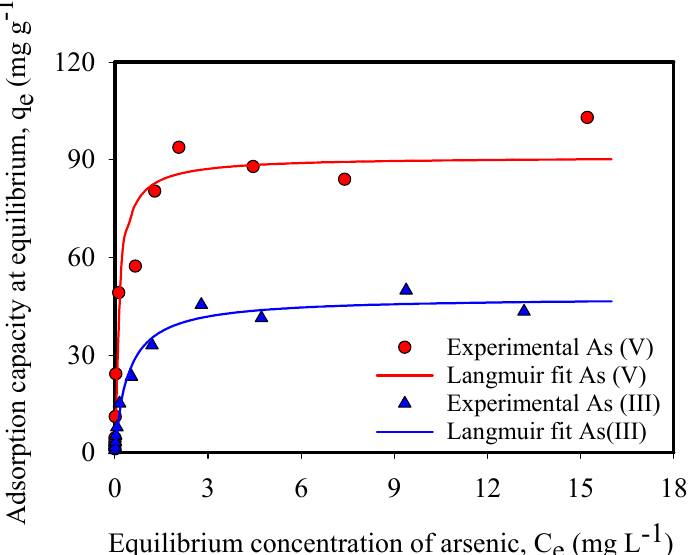
Figure 2. Equilibrium adsorption isotherms of As(III) and As(V). The adsorbent dosage was 63 mg of IONPs L − 1 of arsenic ion.